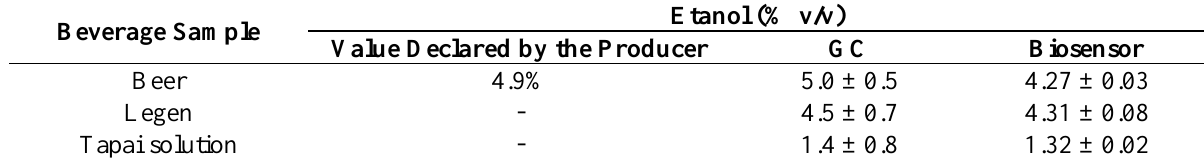
Table 5. Determination of ethanol in the fermented beverage samples with AOX/PANI and by applying GC. Data are give as average ±SD (n =